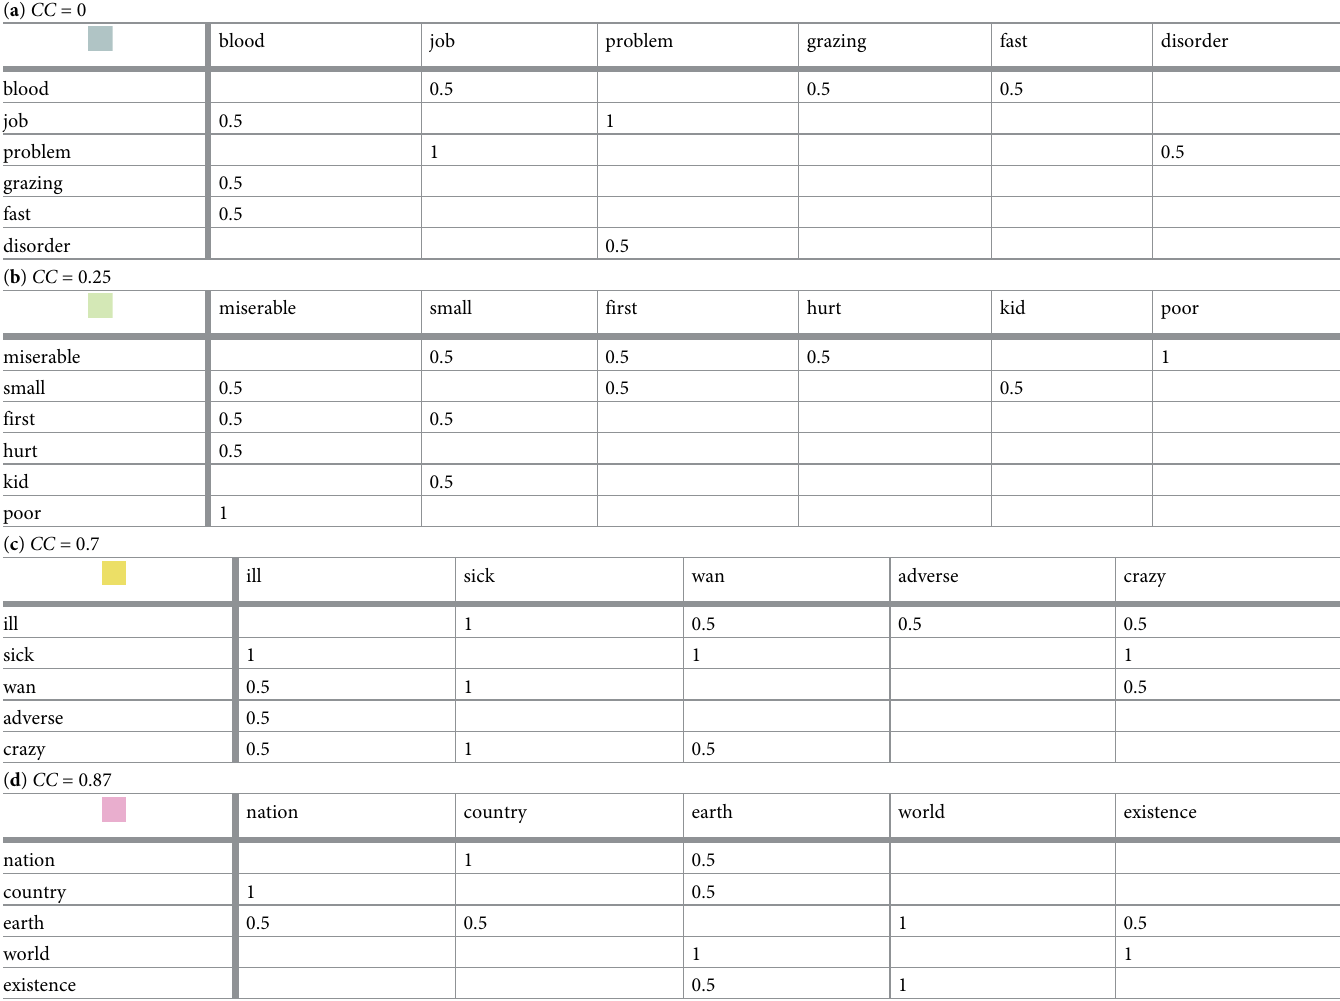
Table 3. Synonym relationships and clustering coefficients ( CC ) of four communities in the text graph. The numbers represent relationship strengths (a strength of 1 is assigned between direct synonyms and 0.5 is assigned between indirect